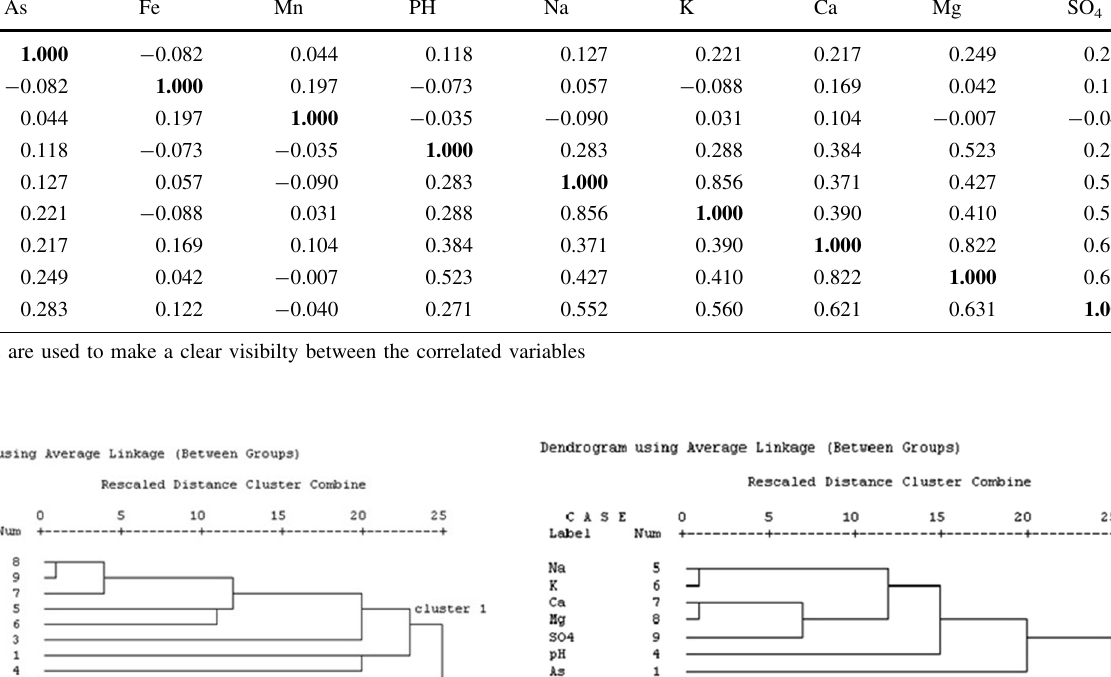
Table 4 Correlation matrix of the trace metal variables in the dry season